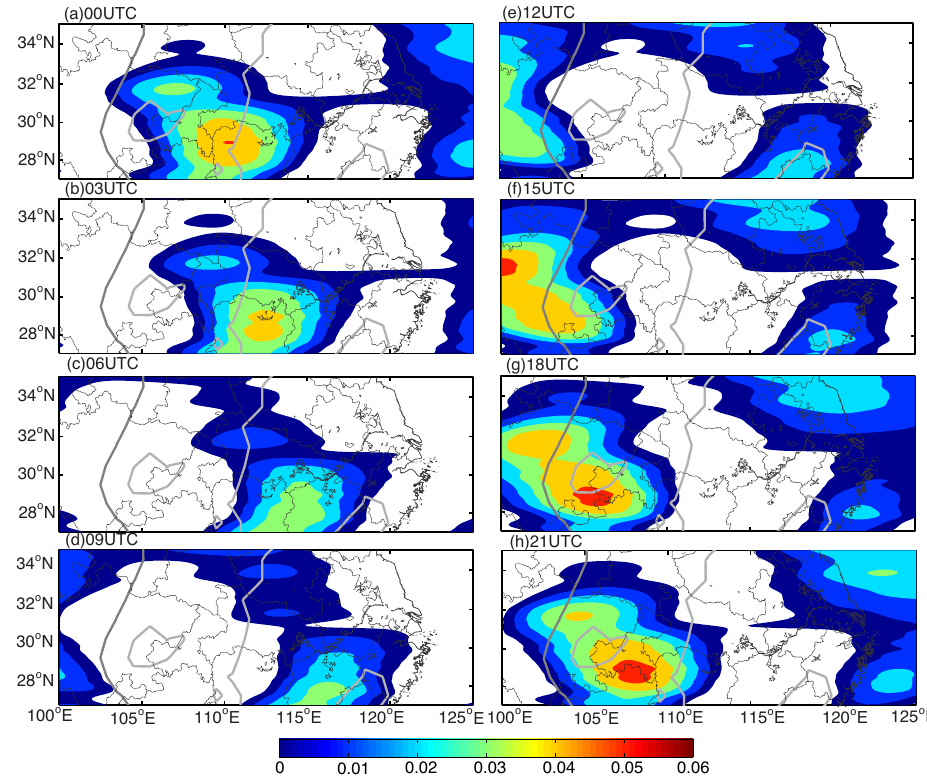
Figure 13. Similar to Fig. 3 but for the filtered precipitation perturbations (units: mmh − 1 ) over spectral range #1 (SR1) for periods between 18–48h and zonal wavelengths between 1400–4000km over East Asia.